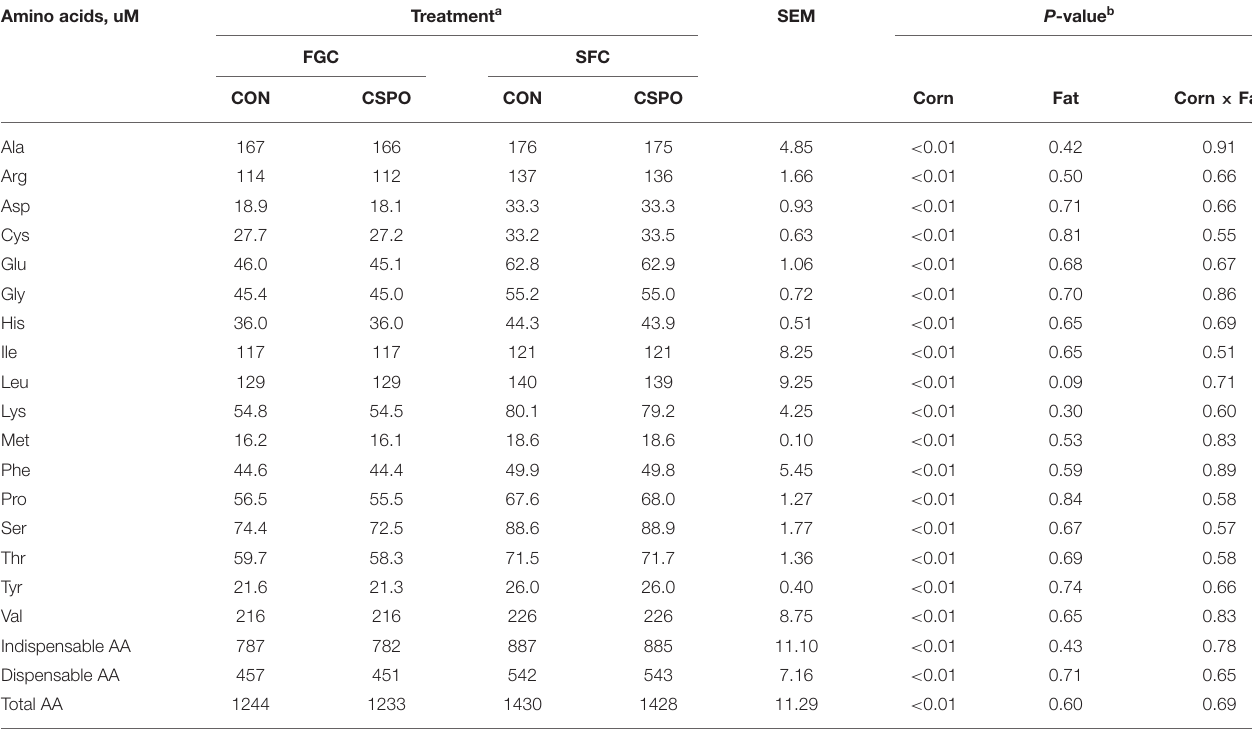
TABLE 3 | Arterial plasma amino acid (AA) concentration of dairy cows receiving the treatment diets (Experiment 1). Amino acids, uM Treatment a SEM P -value b FGC SFC CON CSPO CON CSPO Corn Fat Corn ×